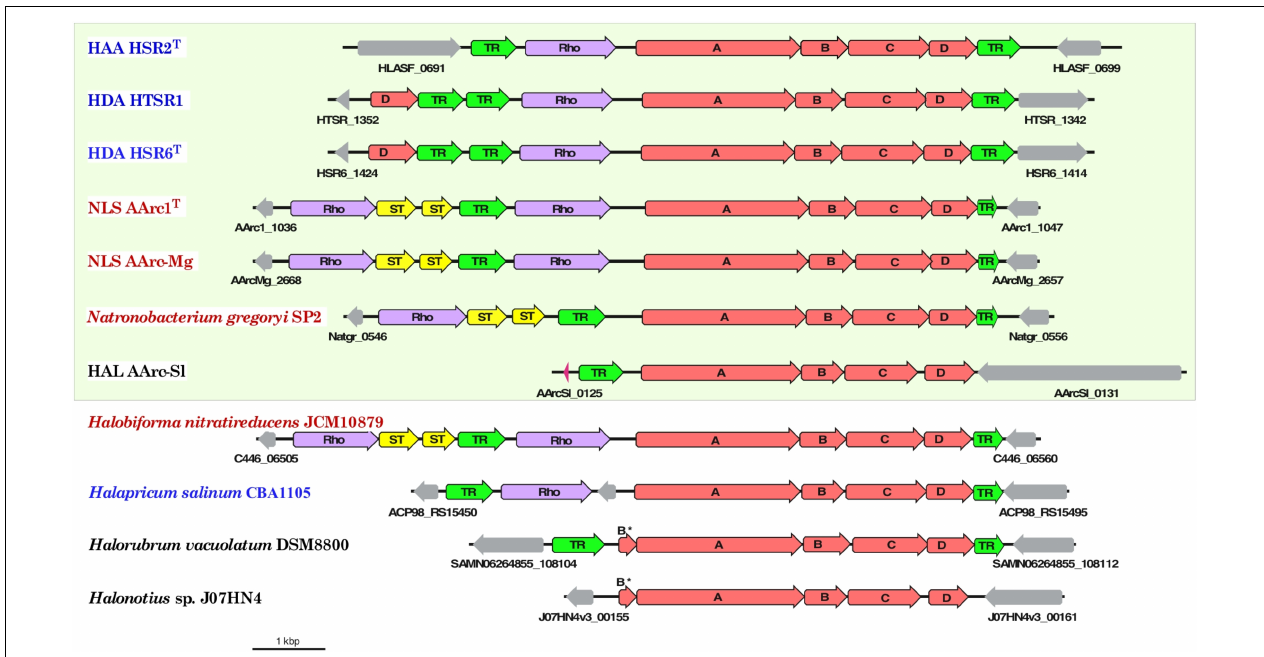
FIGURE 6 | Organization of gene clusters encoding polysulfide reductase (Psr) in haloarchaeal genomes. Arrows show the direction of transcription. Bar represents scale of 1000 bp and the genes are drawn to scale. Organisms with proven capability of lithotrophic sulfur-reducing growth using hydrogen as the electron donor are boxed. The members of orders Halobacteriales , Haloferacales and Natrialbales are highlighted in blue, black and red, respectively. The genes associated with neither Psr reductase subunits (A-D, red) nor sulfur-transferases (ST, yellow), rhodanese-sulfurtransferase (Rho, violet) and transcriptional regulators (TR, green) are shown in gray